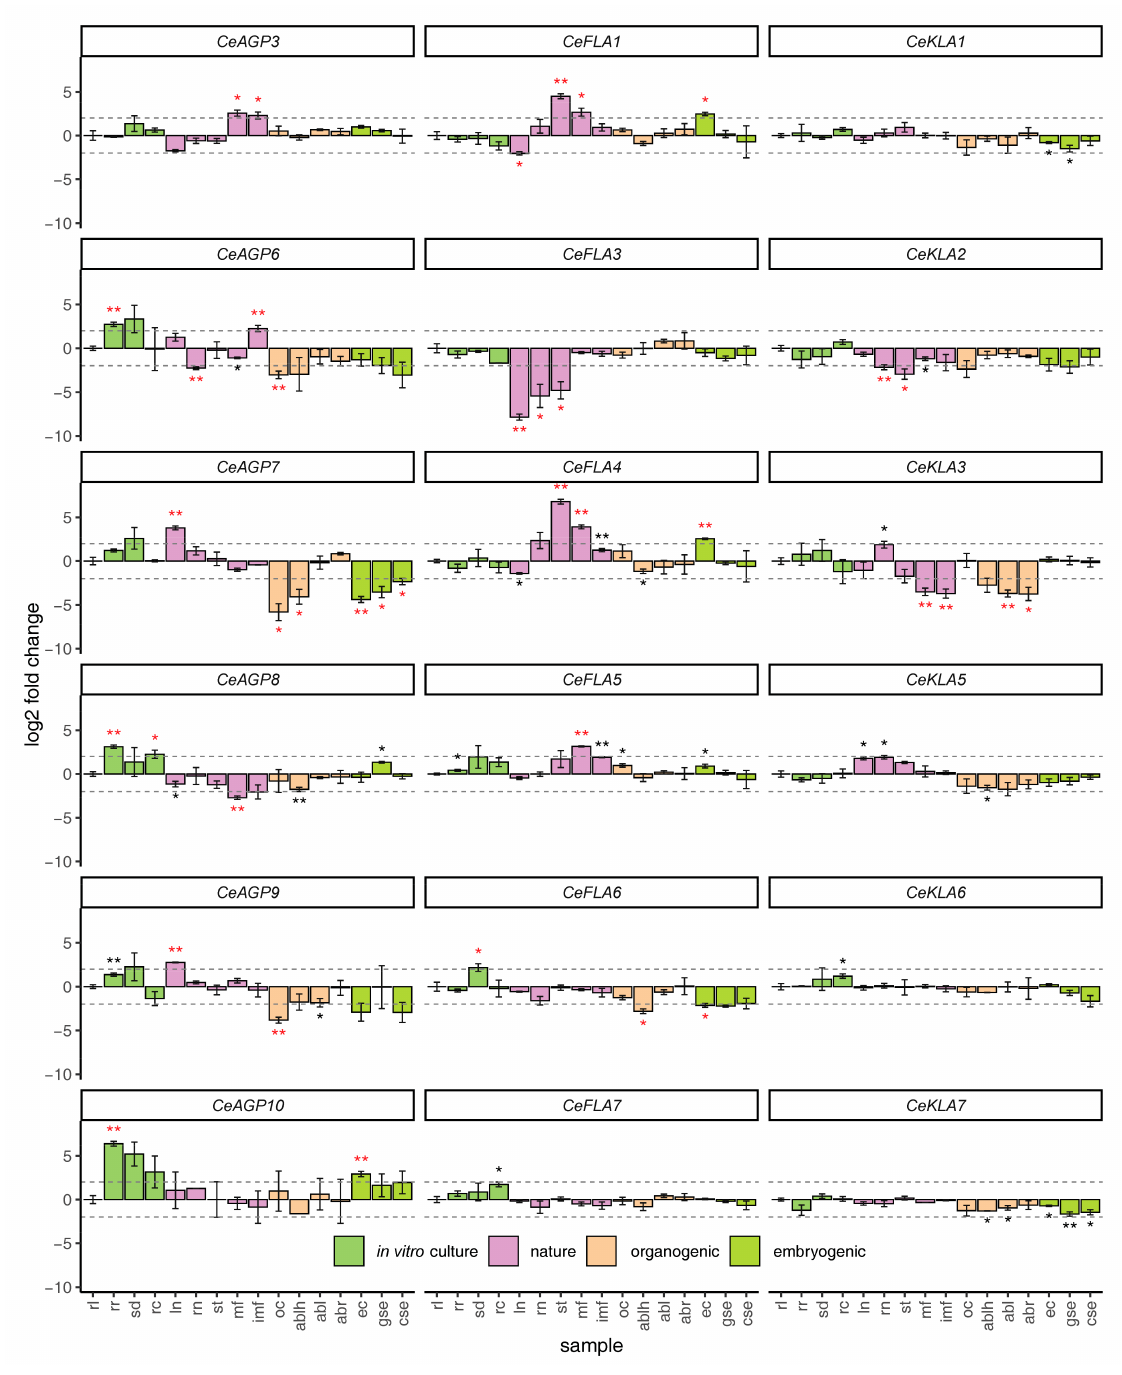
Figure 7. Expression profiles for the 18 studied AGp , FLA and KLA genes in 16 different developmental stages, tissues and plant organs. Sample abbreviations are provided in Table 1. Mean and standard deviation is shown for three biological replicates. The samples correspond to the experimental system explained in more depth in [34]. The horizontal dashed lines represent a log2 fold change of 2 and − 2 compared to the rosette leaves (rl) grown in vitro. Statistical comparison of the means was performed between each sample and the rosette leaves (rl) grown in vitro (control sample) using Welch’s t -test. Multiple comparison correction was performed jointly for all performed comparisons using the Benjamini and Holcberg method. One asterisk (*) indicates that the mean expression in the sample is significantly different compared to the mean control expression (adjusted p -value < 0.05), while two (**) correspond to highly significant difference in expression ( p -values < 0.01). Red asterisks indicate that the comparison of the means is significant and that the difference in the means is higher than 2 log2